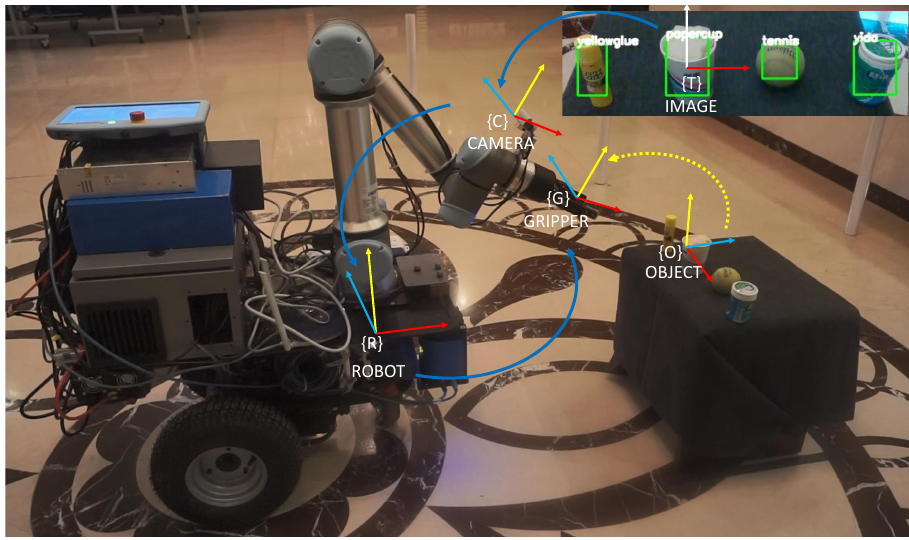
Figure 4. Coordinate transforming from the camera to the robot and